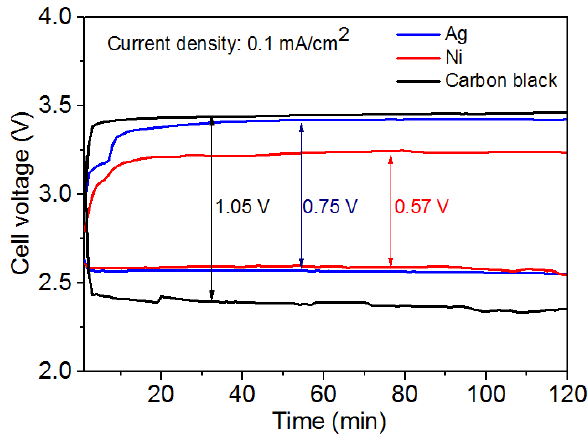
Figure 8. Charge-discharge profiles of nickel nanoparticles as catalysts for hybrid Na-air battery compared with commercial silver nanoparticles and carbon black at the current density of 0.1 mA/cm 2 .